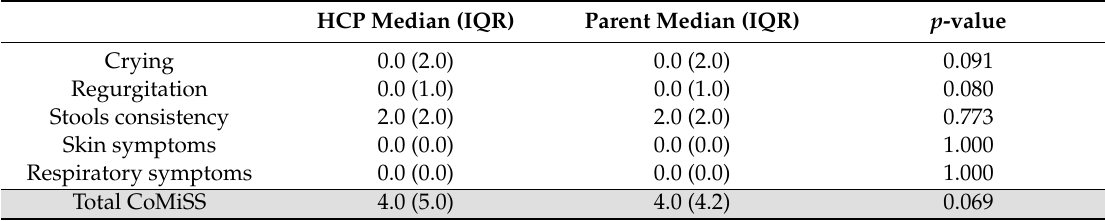
Table 2. Comparison the CoMiSS by a trained health care professional versus parent in a Spanish cohort of presumed healthy infants. HCP Median (IQR) Parent Median (IQR) p -value Crying 0.0 (2.0) 0.0 (2.0)